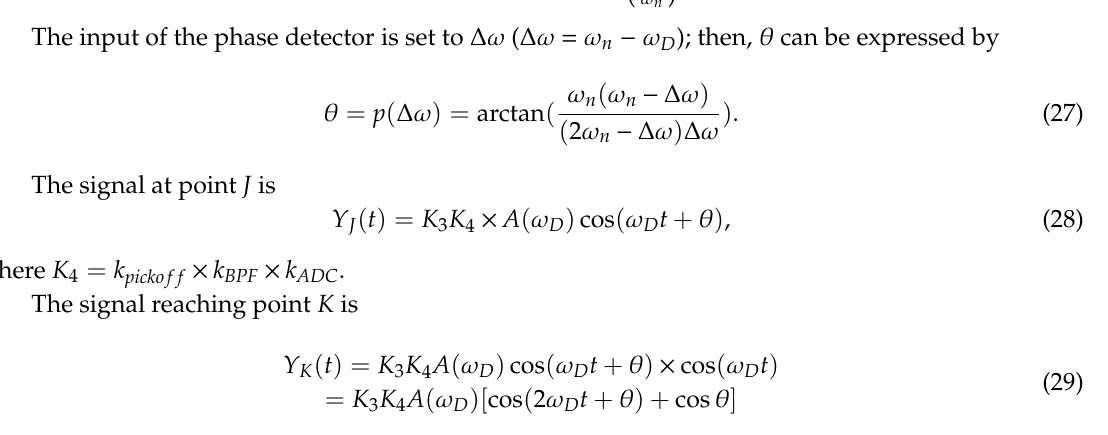
Figure 12. Order ‐ reduction model of PLL.